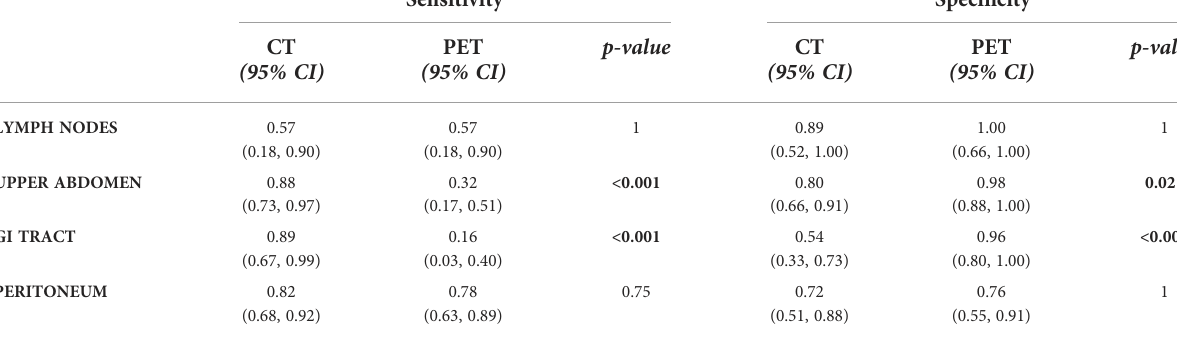
TABLE 4 Sensitivity and speci fi city of CT and PET in identifying metastatic sites compared to